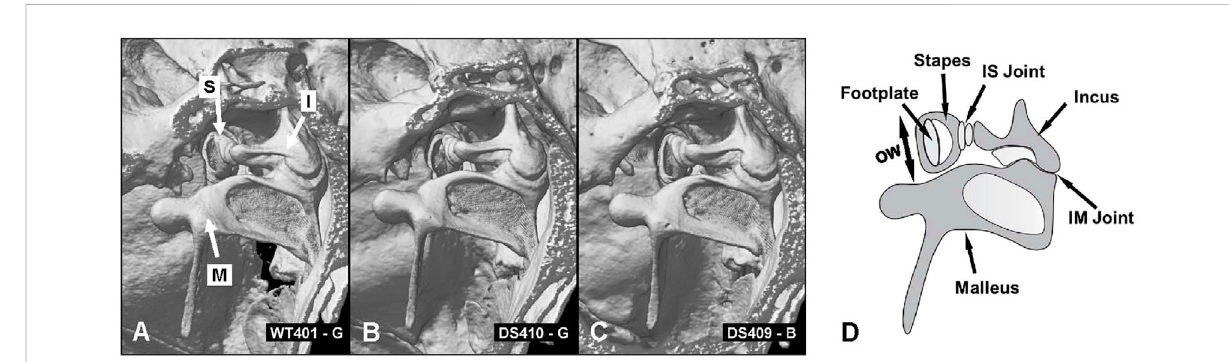
FIGURE 8 No major structural differences between ossicles in WT and DS mice. (A) CT image of three ossicles: stapes (S), incus (I) and malleus (M) of WT mouse compared to same structures in two DS mice, (B) one with near normal thresholds and another (C) with elevated ABR thresholds. (D) Schematic of three middle ear ossicles with footplate of stapes, crus of stapes, incus, malleus, incudostapedial joint (IS) and incudomalleor joint (IM). (D) Schematic of the ossicular chain showing the footplate of the stapes that inserts into the oval window (OW, arrow denotes maximum width of oval window), crus of the stapes, incus, malleus, incudostapedial (IS) joint connecting the head of the stapes to the incus and incudomalleor (IM) joint connecting the incus to the malleus.